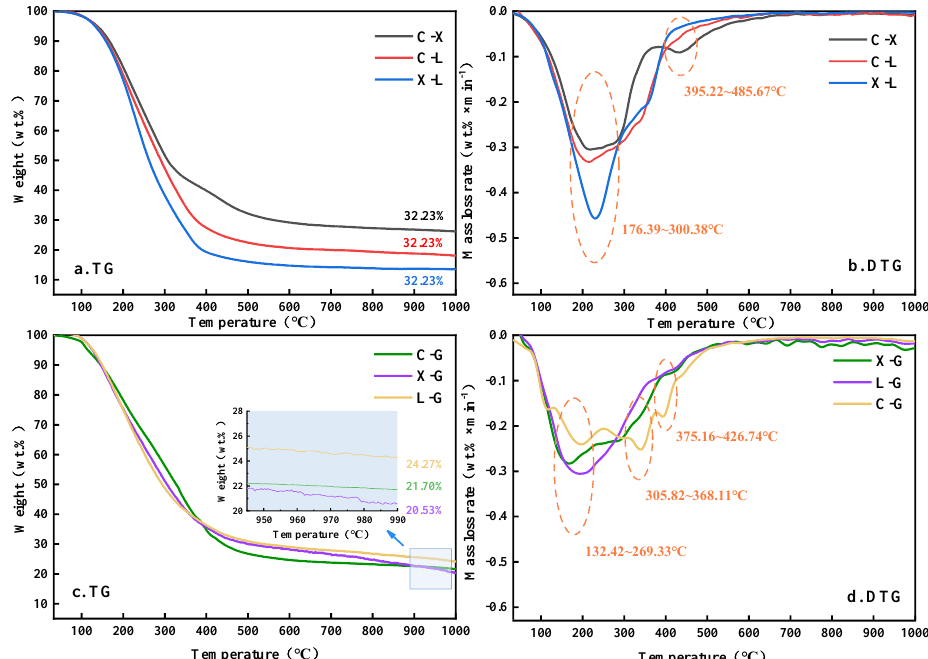
Figure 2. TG − DTG of binary blend hydro-thermal bio-oils with different mono-component. The DTG curves of the cellulose + hemi-cellulose components (C-X) have two obvious weight loss peaks at 230 ◦ C and 430 ◦ C, respectively, which are the same as those of hemi-cellulose (X). This indicates that the weight loss of the mixed samples is mainly caused by hemi-cellulose, the main pyrolysis temperature range of cellulose + hemi-cellulose (C-X) is widened (from 150~310 ◦ C to 100~400 ◦ C), and the weight loss rate is decreased compared with the cellulose DTG curve; and then, the weight loss peak moves to the high-temperature side (the maximum pyrolysis rate peak changed from 210 ◦ C to 230 ◦ C), indicating that the pyrolysis of cellulose mono-component water is inhibited to some extent, which is consistent with the results of Wang et al. [22]. Compared with cellulose, hemi-cellulose can be pyrolyzed in advance at low temperatures, and its liquid state products can be wrapped on the surface of cellulose, which inhibits the volatilization and precipitation of cellulose pyrolysis products, and further improves the temperature limit of cellulose pyrolysis so that the weight loss peak of cellulose extends to the high-temperature side [12]. In addition, most of the volatile components generated during pyrolysis are mostly similar to those of cellulose, which increases the concentration of volatile components in the main pyrolysis temperature range of cellulose, thus, reducing the weight loss rate of